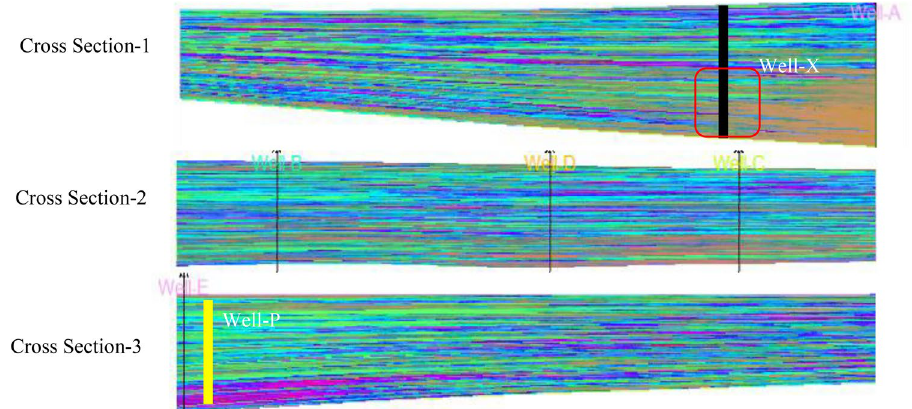
green. C-1, C-2, and C-3 are the cross sections considered for the study of the petrophysical properties along the depth